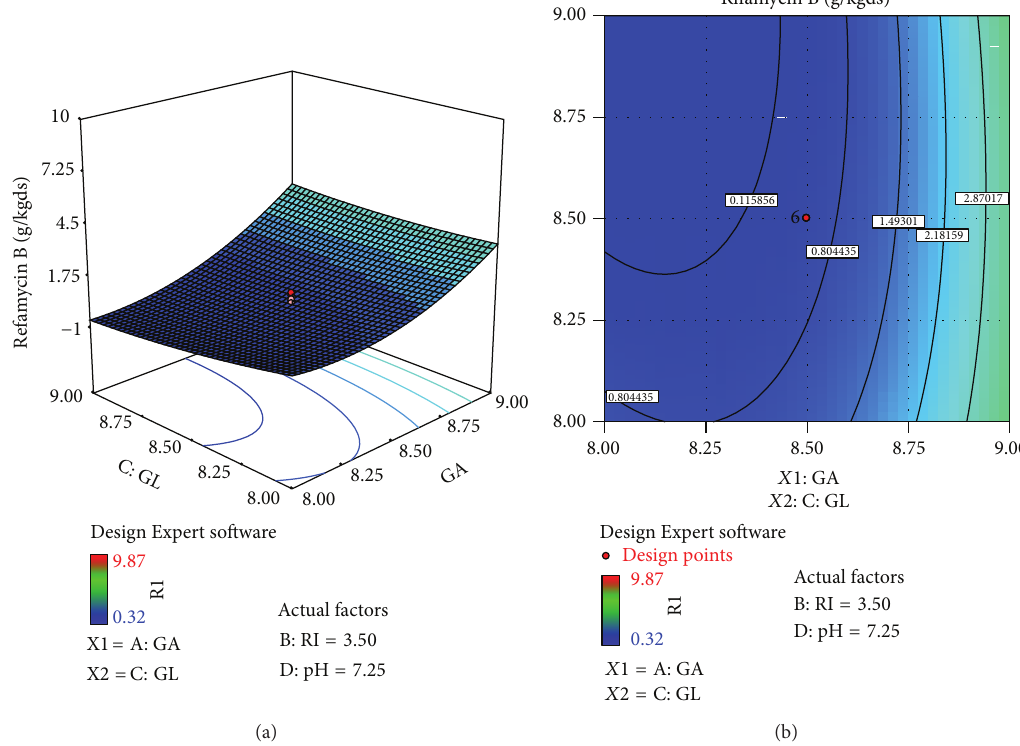
Figure 8: Surface and contour plot for rifamycin B production at varying concentrations of 𝑋4 , galactose (GA), and 𝑋1 , glucose